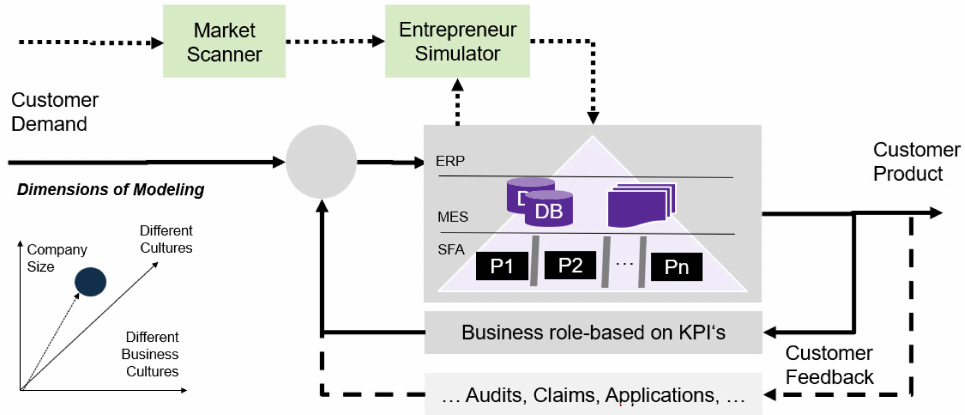
Figure 1. Model of agile, future-orientated Entrepreneur-Structure (own